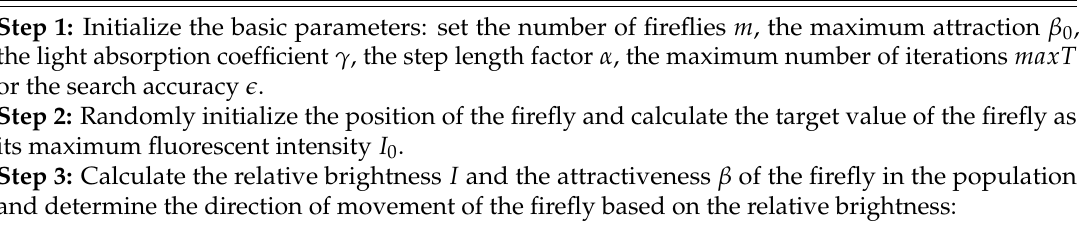
Procedure 2 Glowworm Swarm Optimization